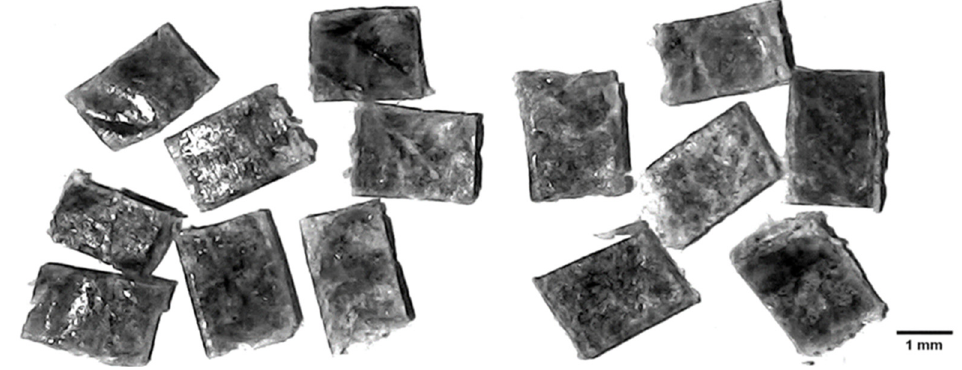
Figure 1. CFW pellets.